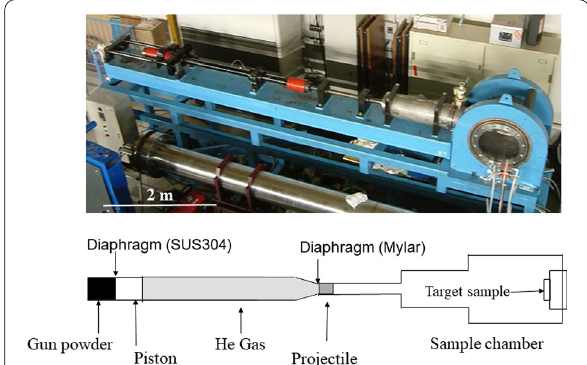
Fig. 1 The two-stage light gas gun (installed at Institute of Fluid Science, Tohoku University) used for impact experiments to simulate the formation of a Neumann band. A schematic image of the instrument components is also